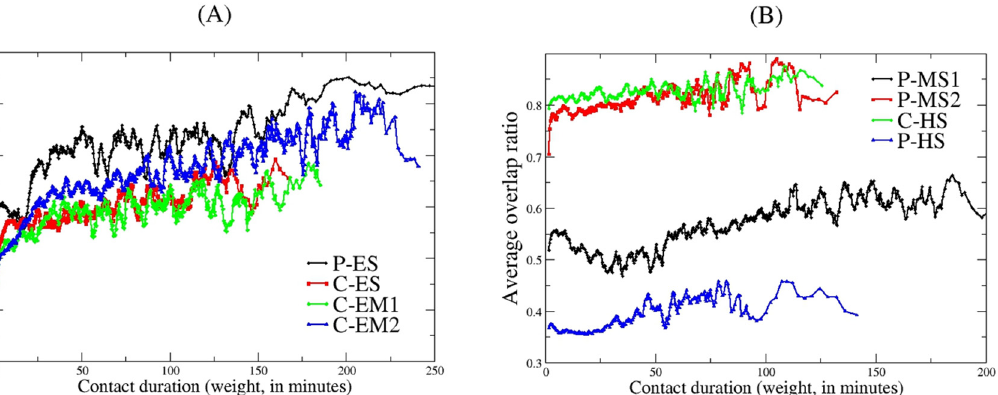
Fig 7. Average overlap ratio versus contact duration. (A) Elementary and elementary-middle schools (B) Middle and high schools. C: Charter school; P: Public school; ES: Elementary school; EM: Elementary-middle school; MS: Middle school; HS: High